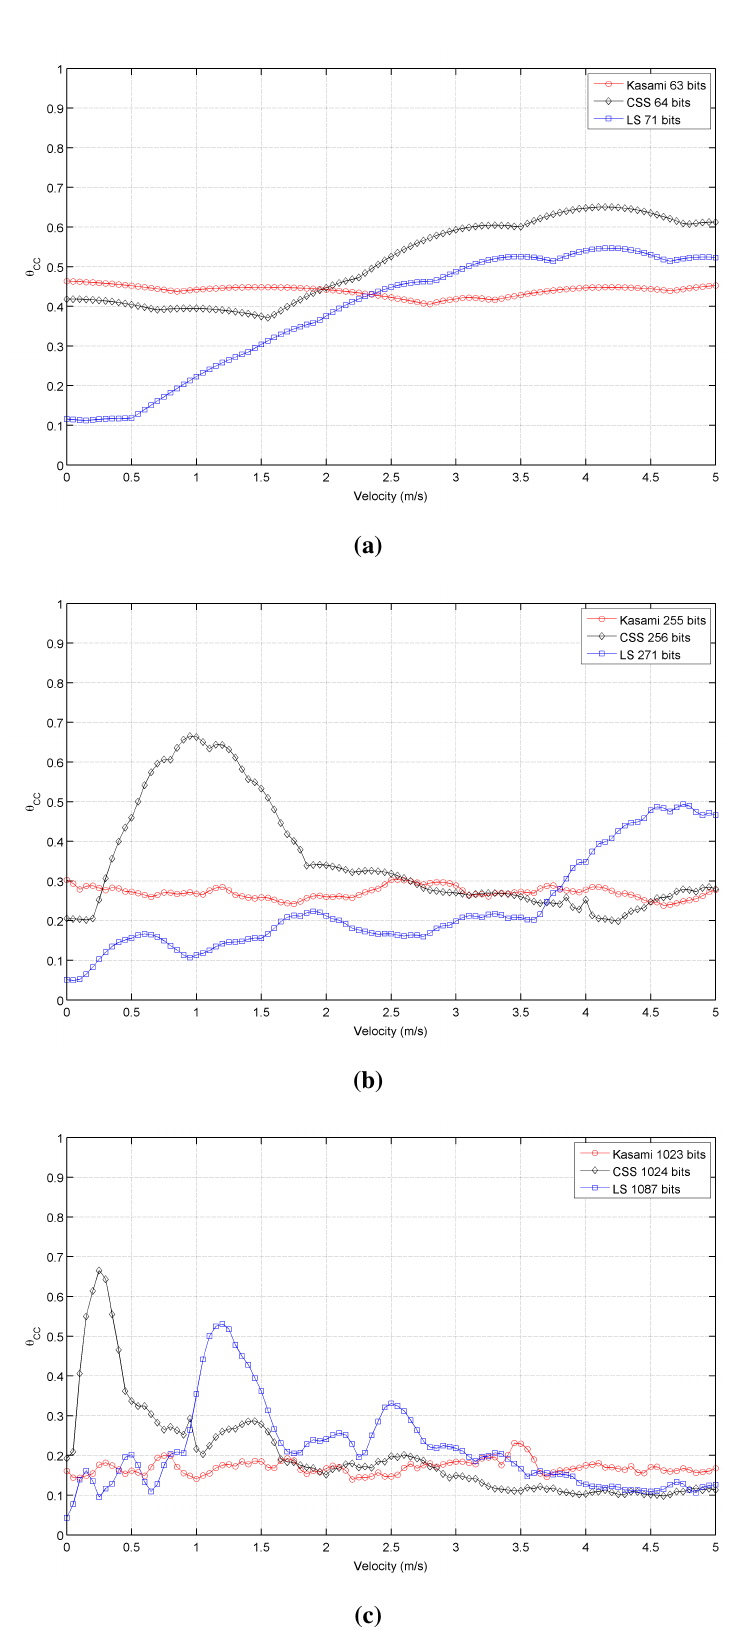
Figure 6. Simulated cross-correlation bound for the sequences with lengths close to (a) 64 bits (b) 256 bits (c) 1,024 bits (transducer response and atmospheric absorption are